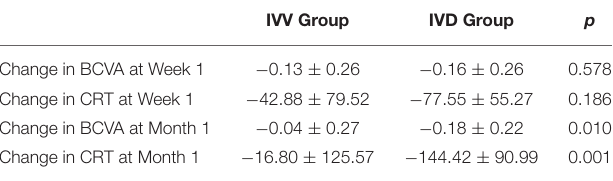
TABLE 4 | Change in BCVA (logMAR) and CRT ( µ m) in the two groups.